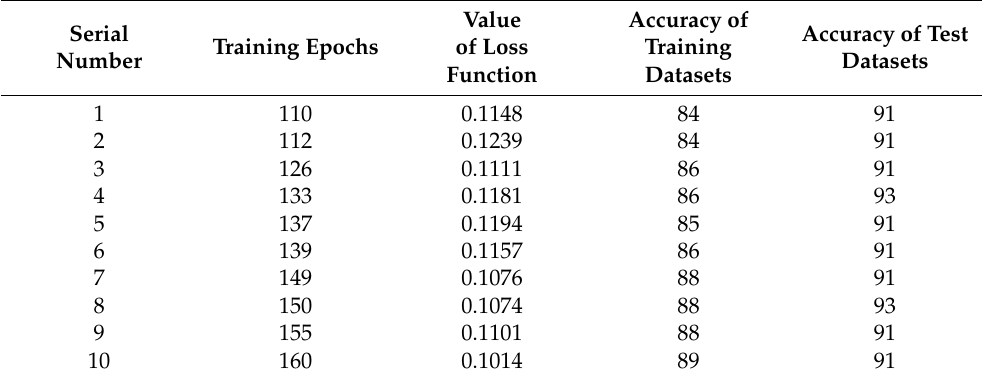
Table 3. The training cycles and loss function values with high accuracy were obtained by the CapsNets